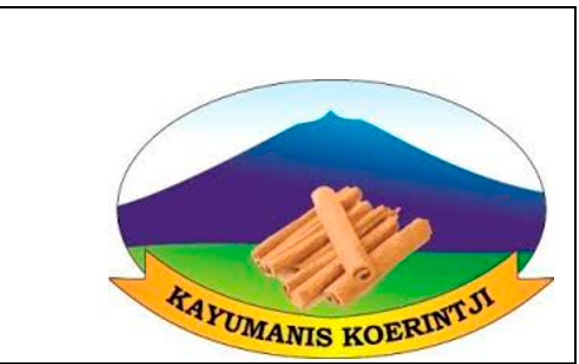
Figure 4. The Koerintji Cinnamon GI label. Source: GI Koerintji cinnamon—books of